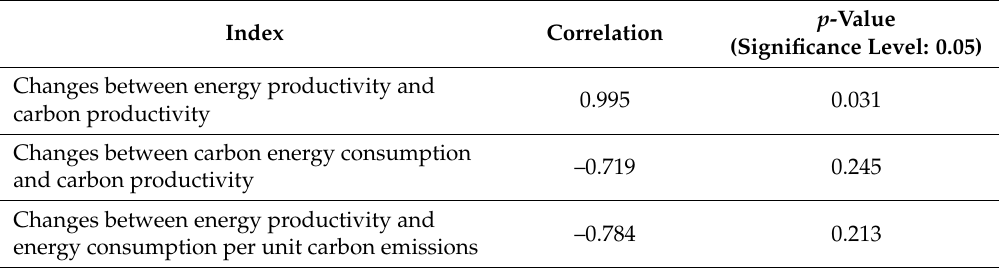
Table 10. Coefficient of carbon productivity